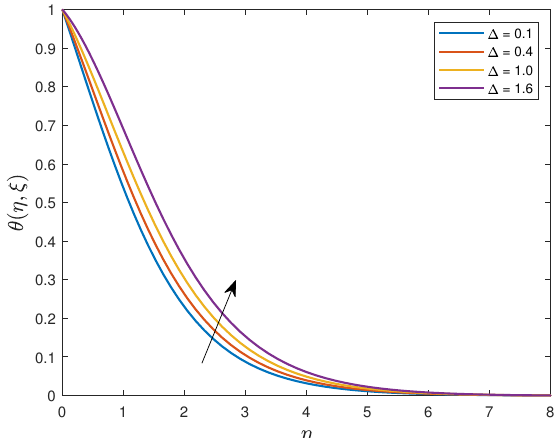
Figure 31. The influence of ∆ on fluid velocity.